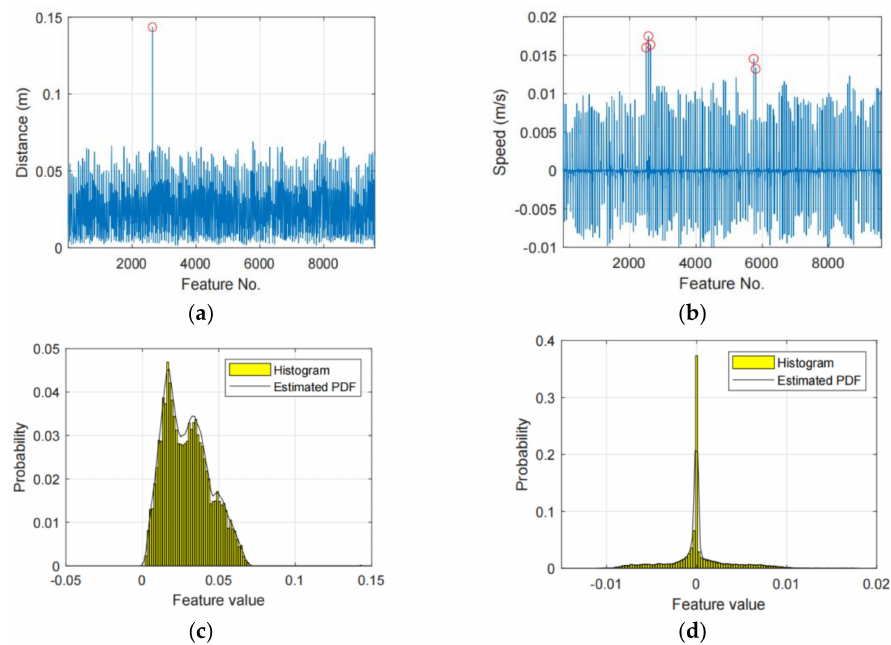
Figure 3. Two examples of unreliable feature, in which ( a , b ) plot the tracker distance features and gait speed, respectively, the unreliable features are marked with red circles, ( c , d ) plot the distribution of ( a , b ),